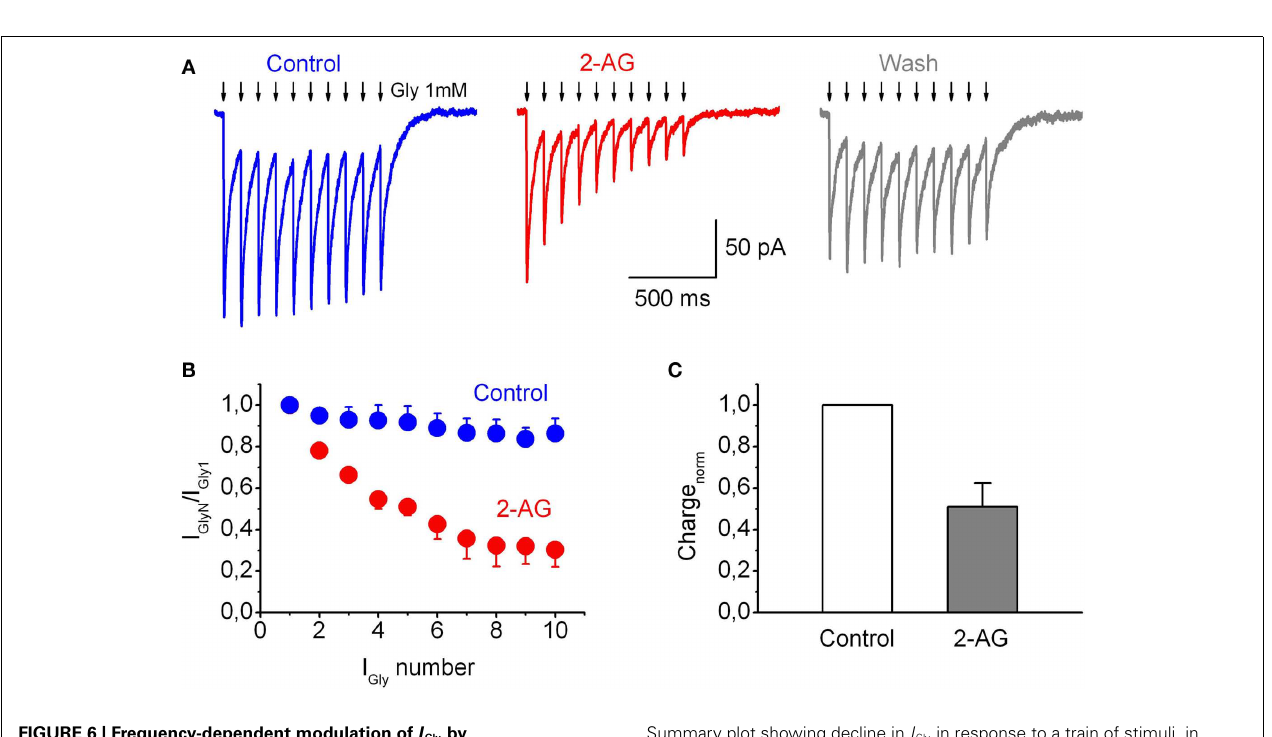
FIGURE 6 | Frequency-dependent modulation of I Gly by endocannabinoids in outside-out patches. (A) Representative traces of I Gly induced by the train (10Hz, 10 pulses) of 10 short (2ms) applications of Gly (1mM) in control ( left ), in the presence 2-AG (1 μ M; Middle ), and after wash-out of 2-AG ( right ). Arrows indicate the glycine applications. (B)